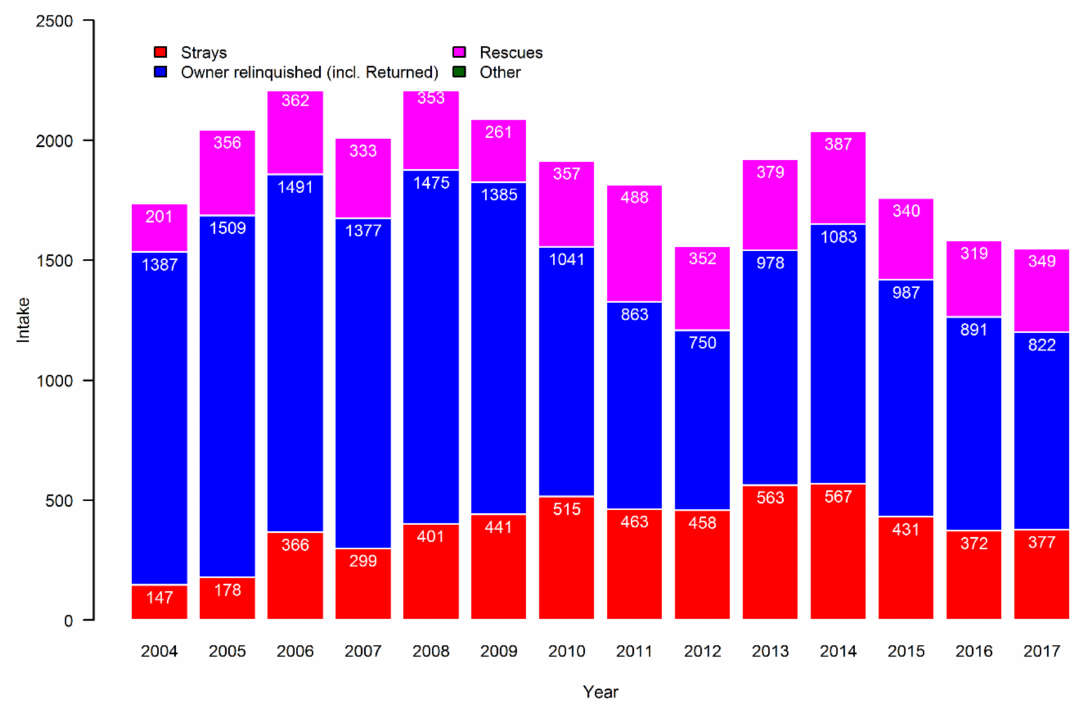
Figure 3. Sources of dogs in the Danish shelters over the study period from 2004 to